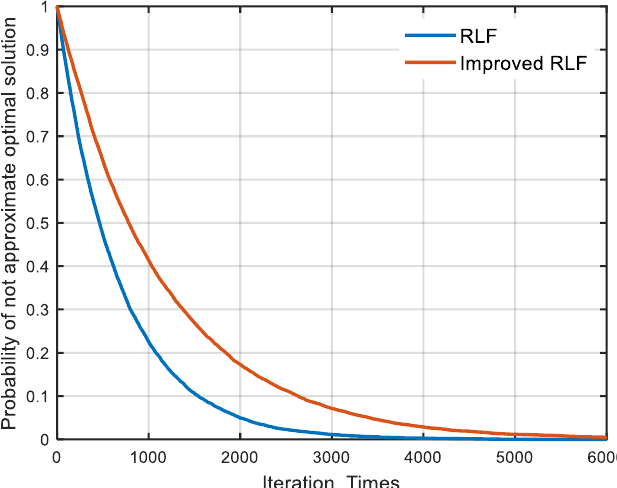
Figure 7. The probability of not approximate optimal solution varying with the number of iterations. The experimental method is the same as that in Figure 6.